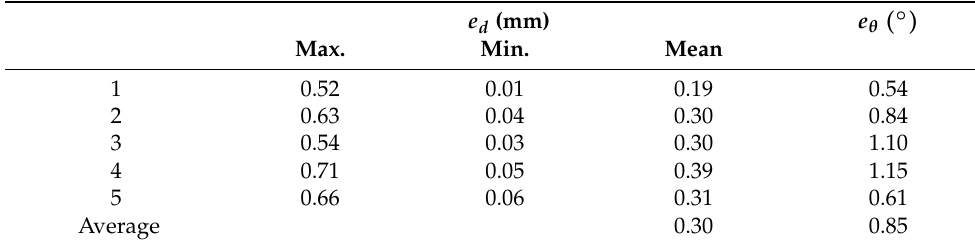
Table 1. Results of the US probe calibration.